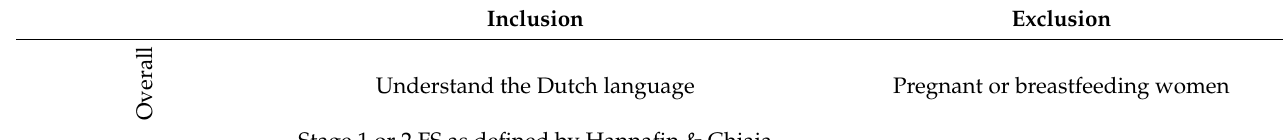
Table 1. Eligibility